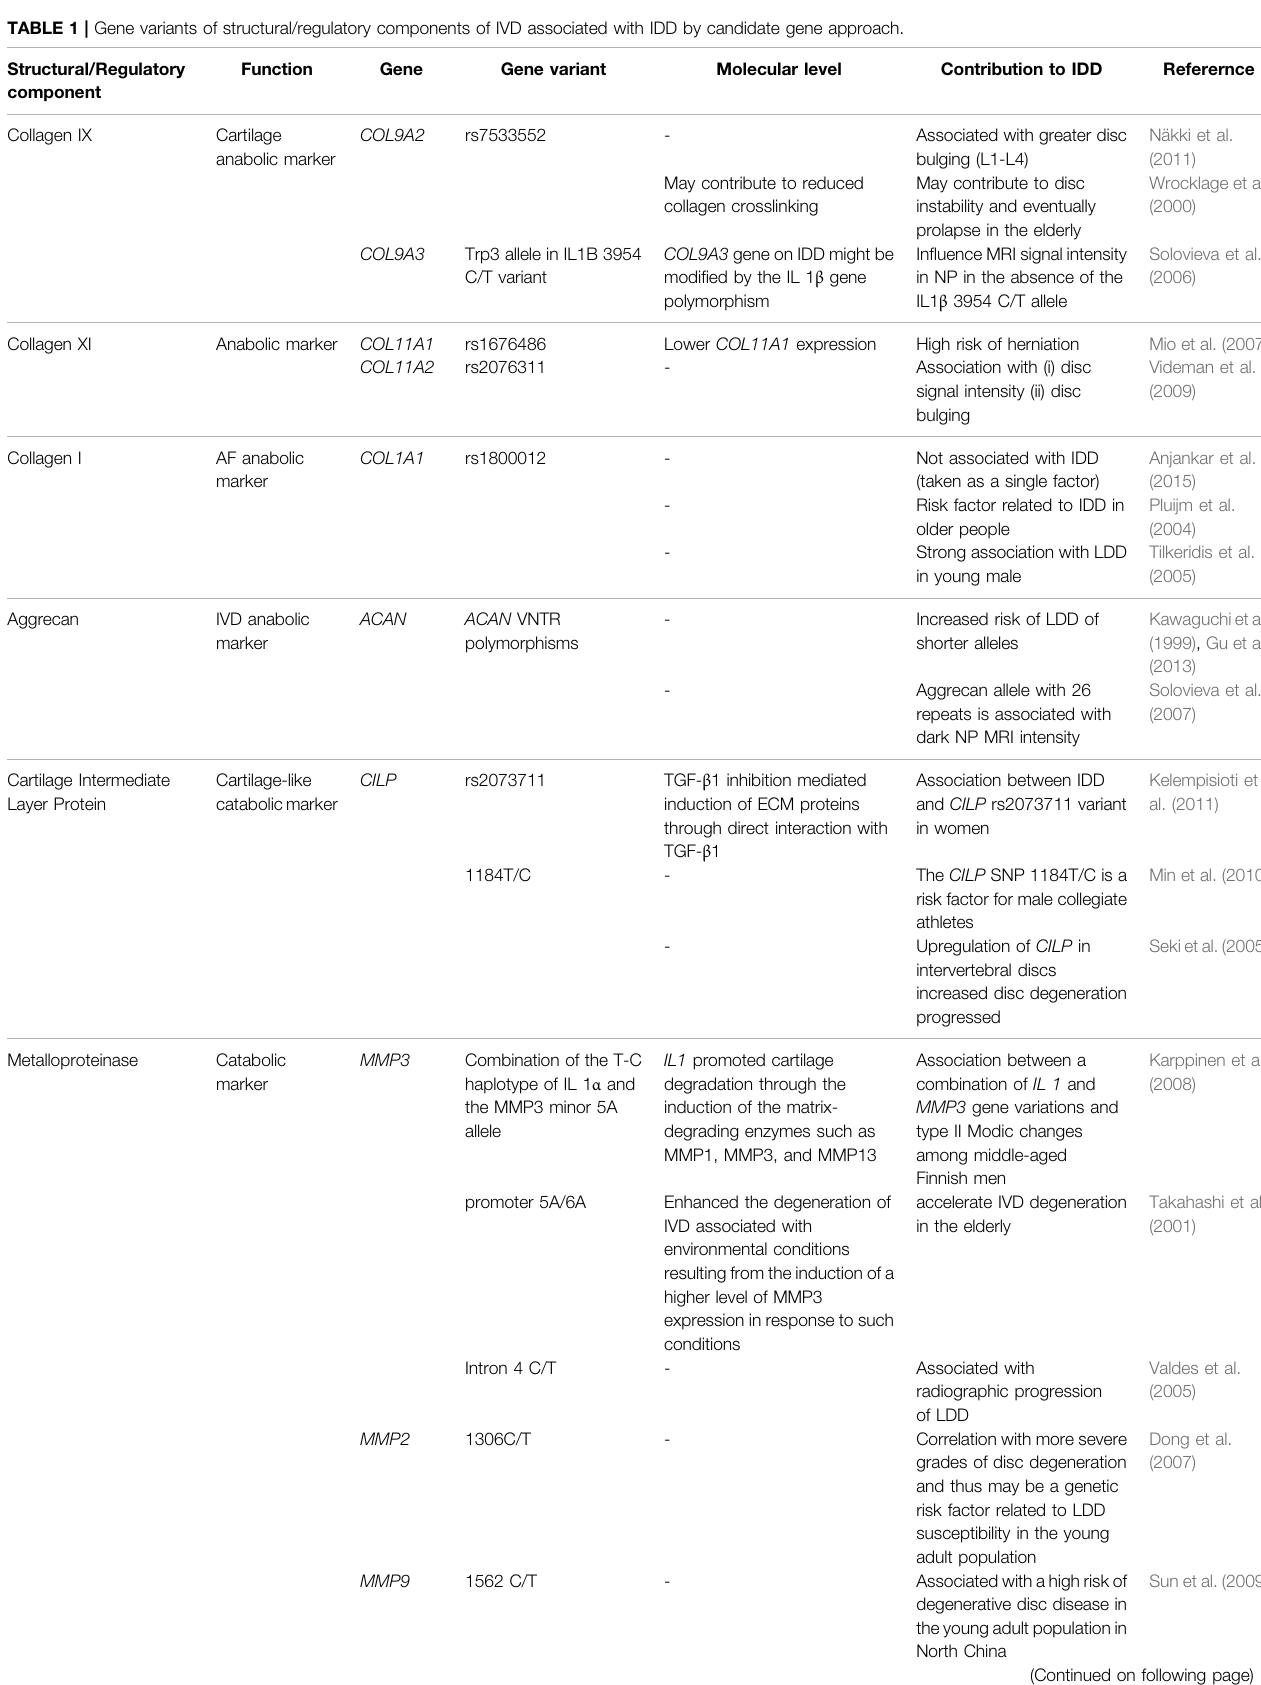
TABLE 1 | Gene variants of structural/regulatory components of IVD associated with IDD by candidate gene